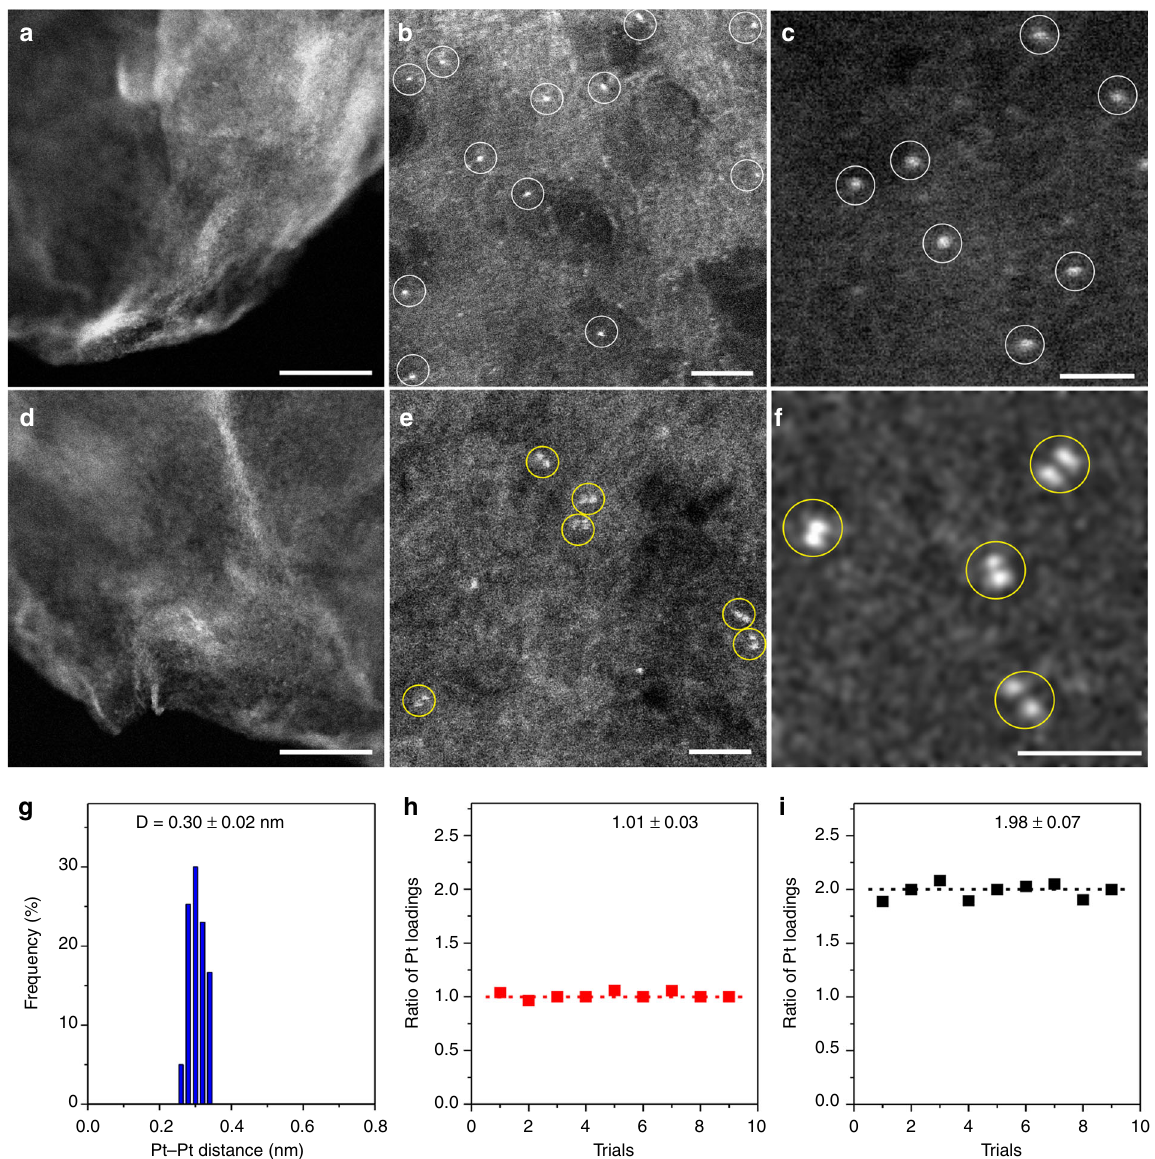
Fig. 2 Morphology of the single-atom Pt 1 /graphene and dimeric Pt 2 /graphene catalysts. Aberration-corrected HAADF-STEM images of Pt 1 /graphene ( a – c ) and dimeric Pt 2 /graphene ( d , e ). Scale bars, 20 nm ( a , d ), 2 nm ( b , e ), and 1 nm ( c , f ). Pt single atoms in b and c and dimers in e and f are highlighted by white and yellow circles, respectively. g Statistical Pt – Pt distance in the observed Pt 2 dimers. h The ratio of Pt loading of in Pt-MeCpPtMe/ graphene to that in MeCpPtMe/graphene, and i the ratio of Pt loading in Pt 2 /graphene to that in Pt 1 /graphene in nine independent trials determined by